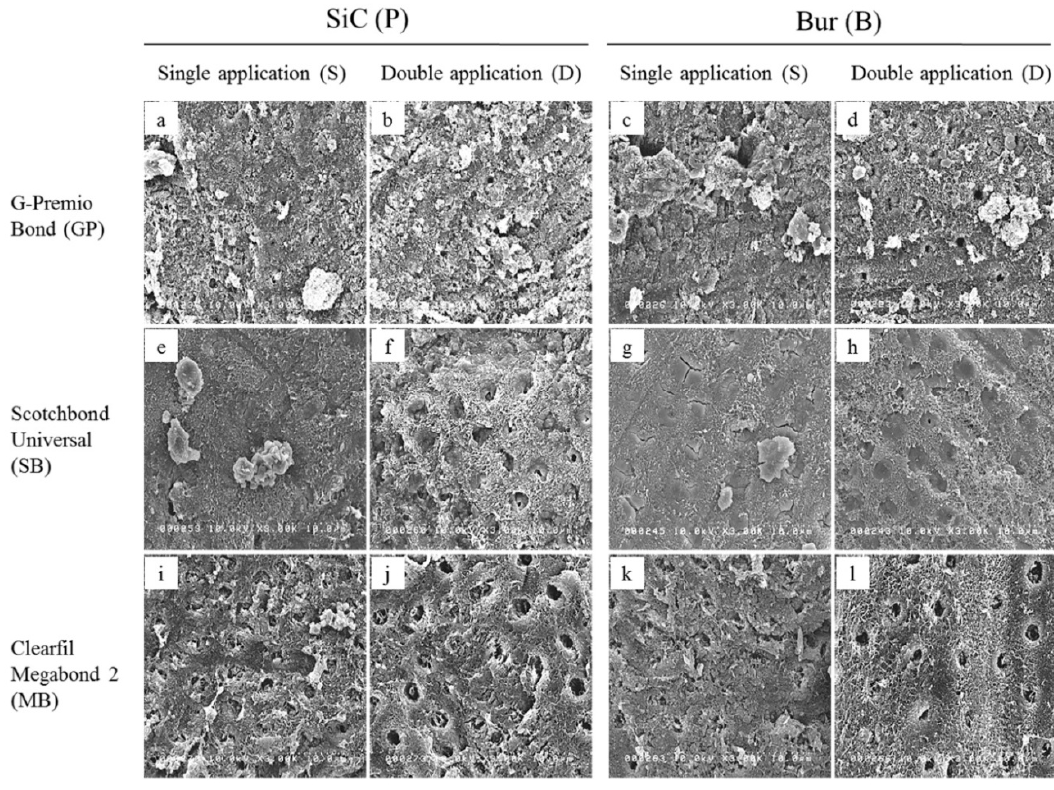
Figure 4. Representative SEM images (3000×) of 180-grit SiC paper-prepared (P) and fine-grit diamond bur-cut (B) dentin conditioned with the tested adhesives (GP and SB) and primer (MB) when applied in single ( a , e , i , and c , g , k ) and double application mode ( b , f , j , and d , h , l ).